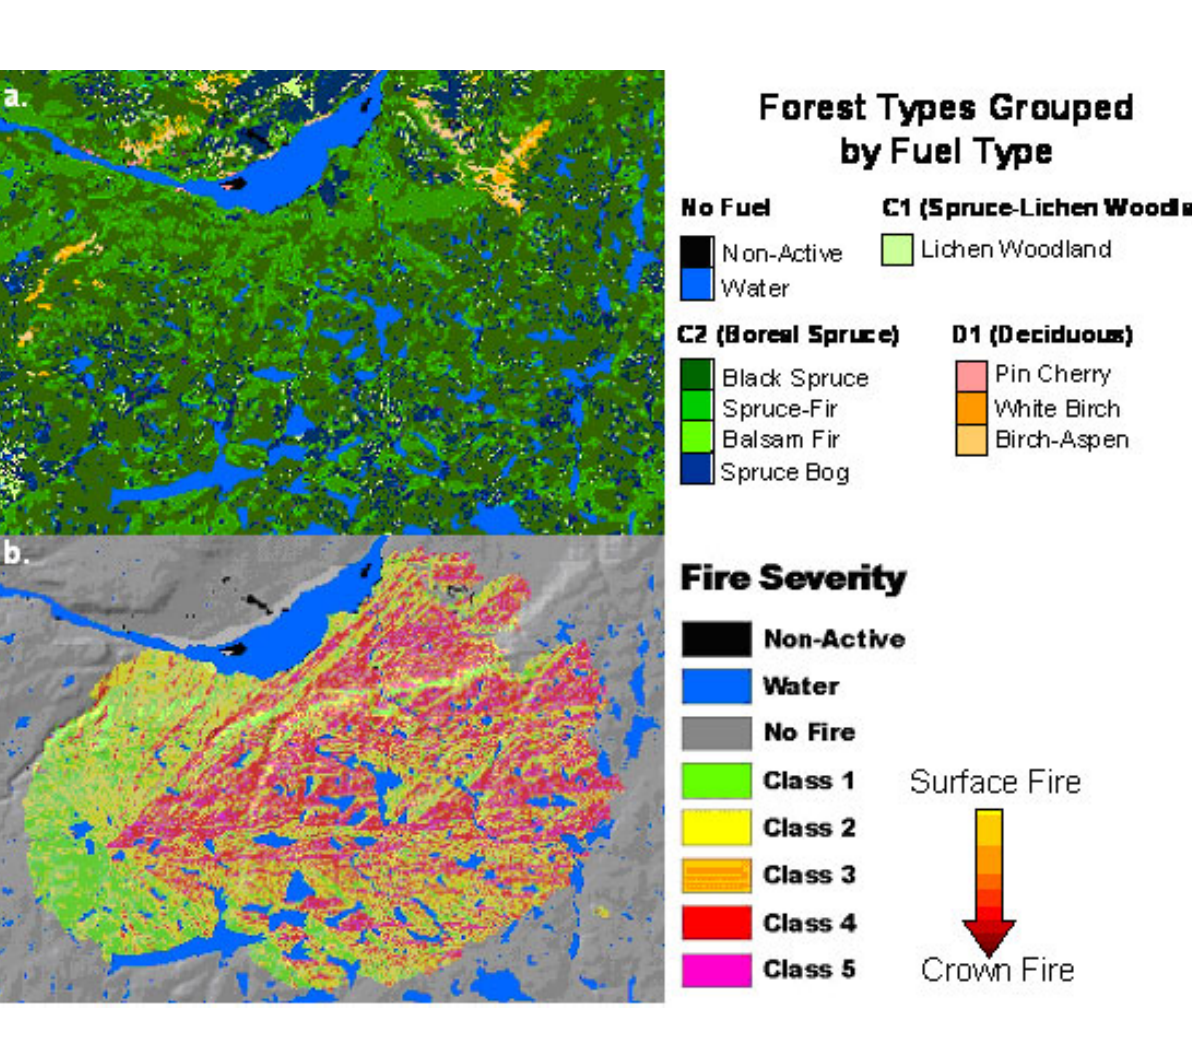
Figure A2. a. Forest cover types from LANDIS-II translated into fuel types the Canadian Forest Fire Behavior Prediction (FBP) System. b. A simulated fire event and resulting fire severity pattern responding to the landscape configuration of fuel types, using fire spread equations from the Canadian